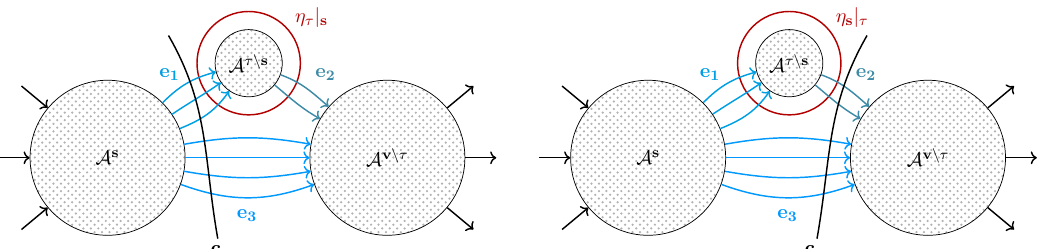
= − η . The direction of the edges τ | s s | τ